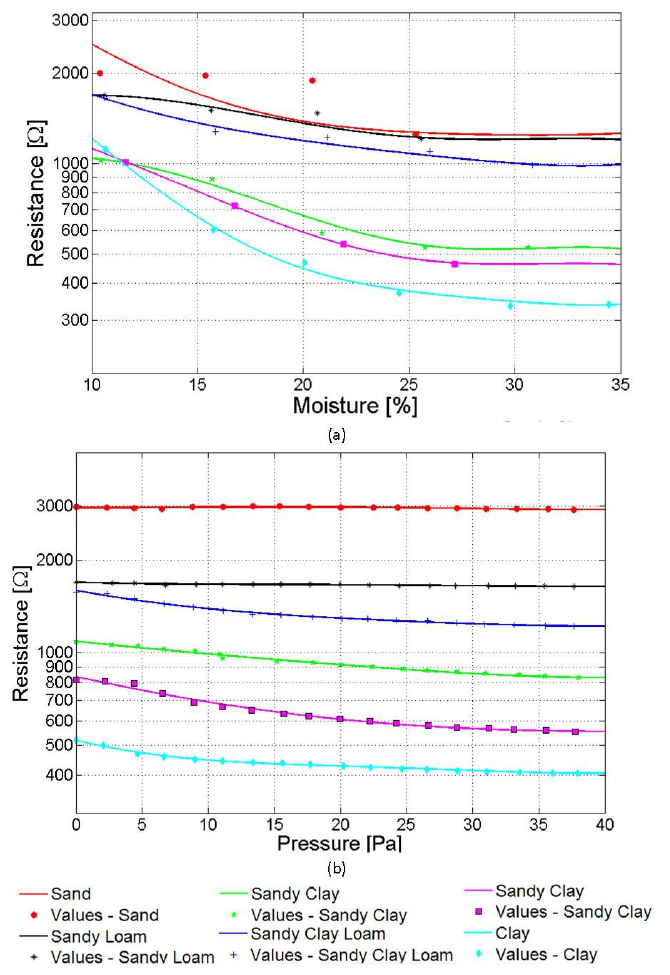
Fig. 7. Correlation Curves: (a) R m x w x δ and (b) R m x C x